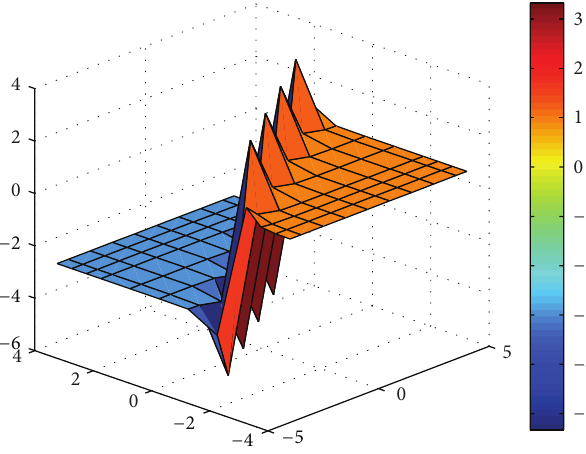
Figure8:Thesolitarywaveandbehaviorofthesolutions 𝑢(𝑥, 𝑦, 𝑡) = −1 + tanh (𝑥 − 2𝑦 + 𝑡)/(1 + sech (𝑥 − 2𝑦 + 𝑡)) + (1 + sech (𝑥 − 2𝑦 + 𝑡))/ tanh (𝑥 − 2𝑦 + 𝑡) for 𝑡 = 0 , −4 ⩽ 𝑥 ⩽ 4 , and −4 ⩽ 𝑦 ⩽ 4